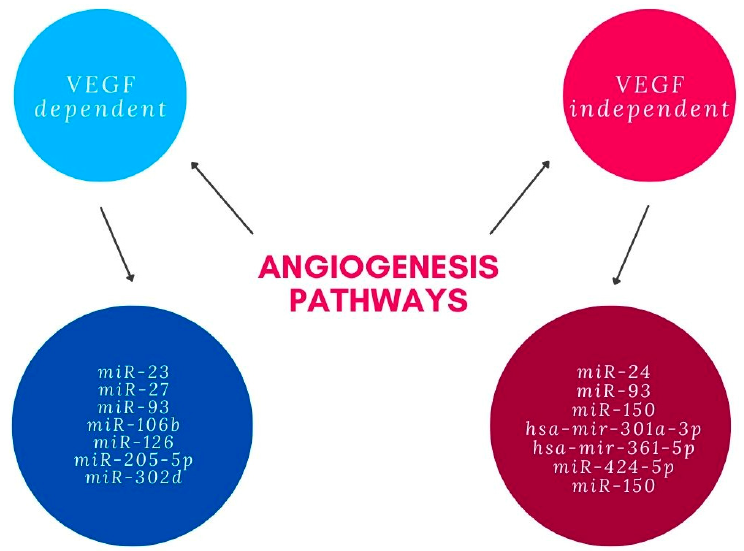
Figure 1. miRNAs involved in angiogenesis